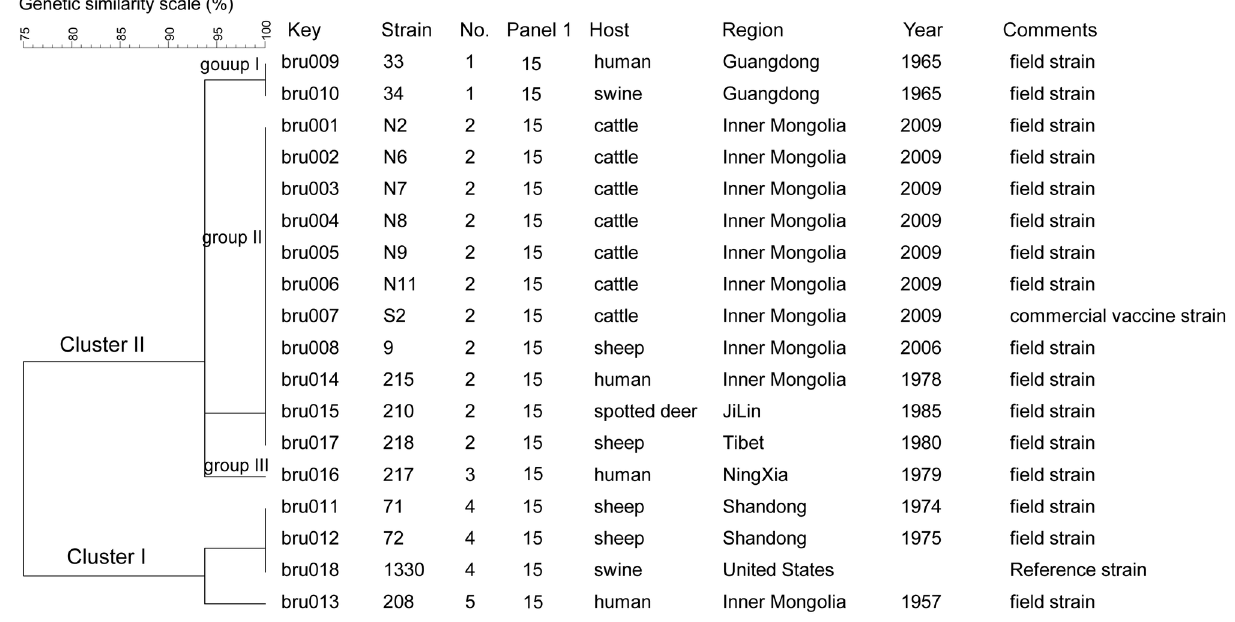
Figure 3. Dendrogram based on the MLVA-16 genotyping assay showing relationships of the 18 B. suis biovar 1 strains in this study. In the columns, the following data for isolates are indicated: Key: serial number for the isolate in the Brucella2012MLVA database (Key), strain name in the laboratory (strain), genotype numbering (No.), Panel1 genotypes corresponding to each isolate in the Brucella2012, geographic region (Region), year of isolation (Year). doi: